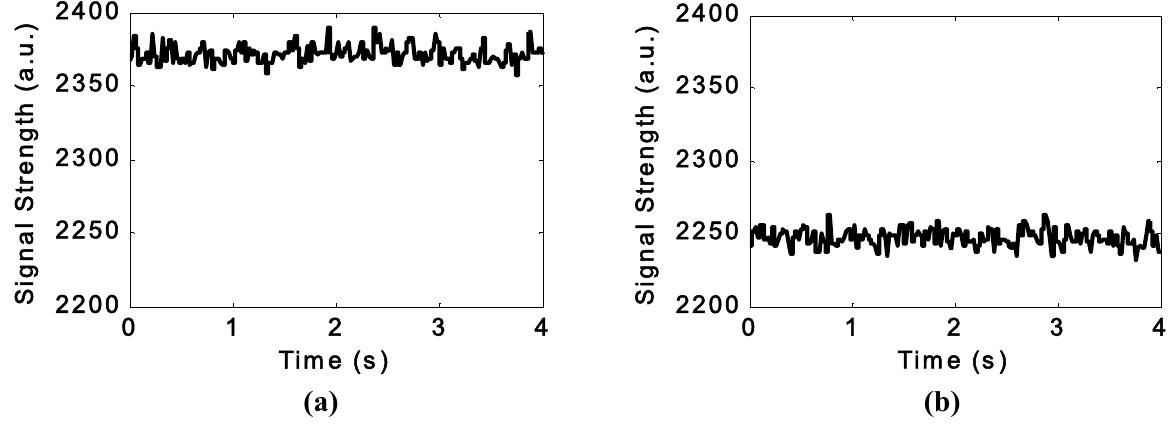
Figure 9. The response of the dual-axis accelerometer as a car is revved whilst parked on top of the buried pipe (a) x-axis, (b)